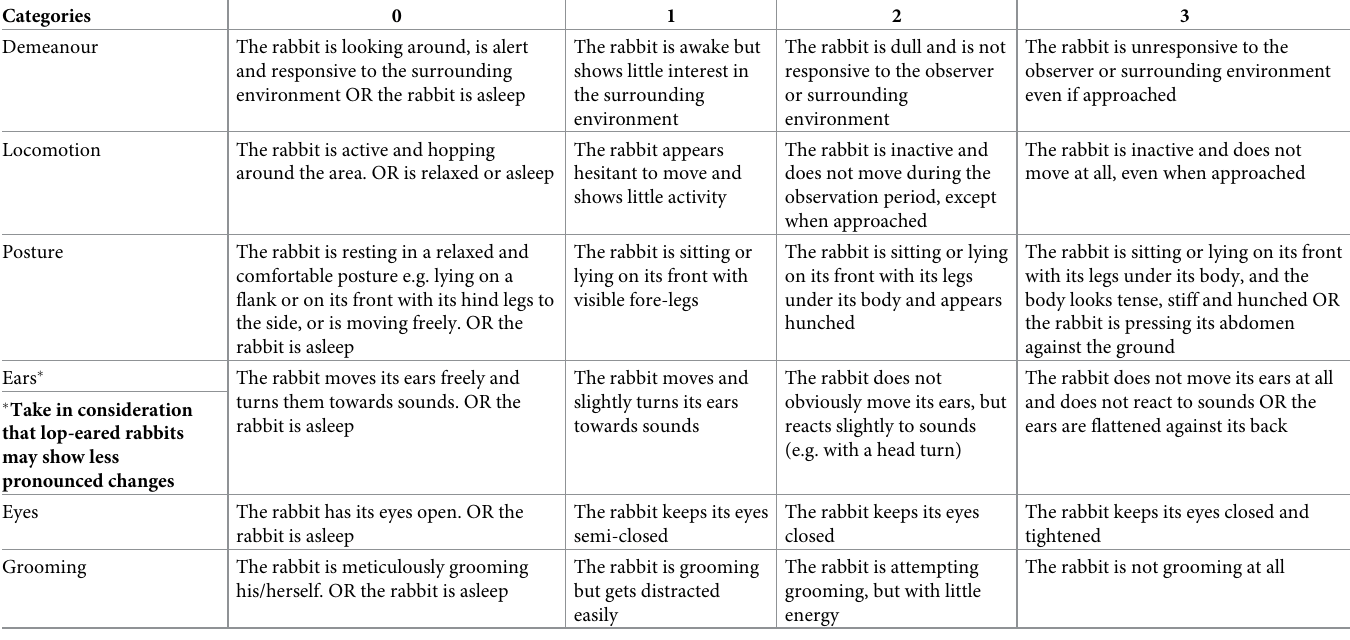
Table 6. Final version of the Bristol Rabbit Pain Scale